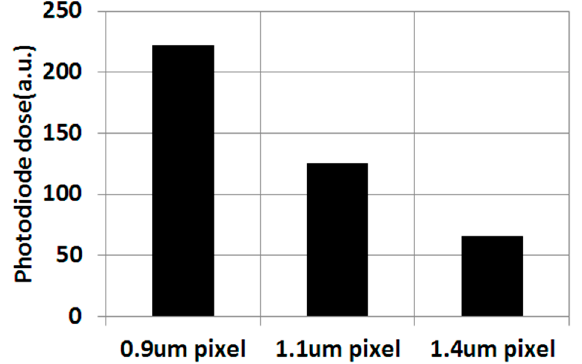
Figure 6. Pixel generation vs. the photodiode implant dose.